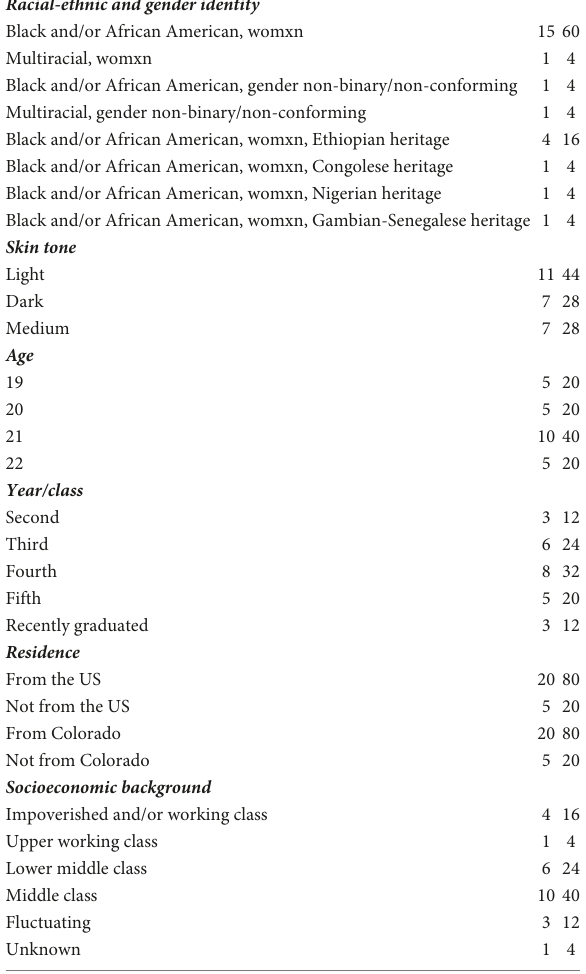
TABLE 1 Demographics of narrators from one-on-one interviews with Black womxn and femme undergraduate students: Racial-ethnic and gender identity, skin tone, age, year/class, residence, and socioeconomic